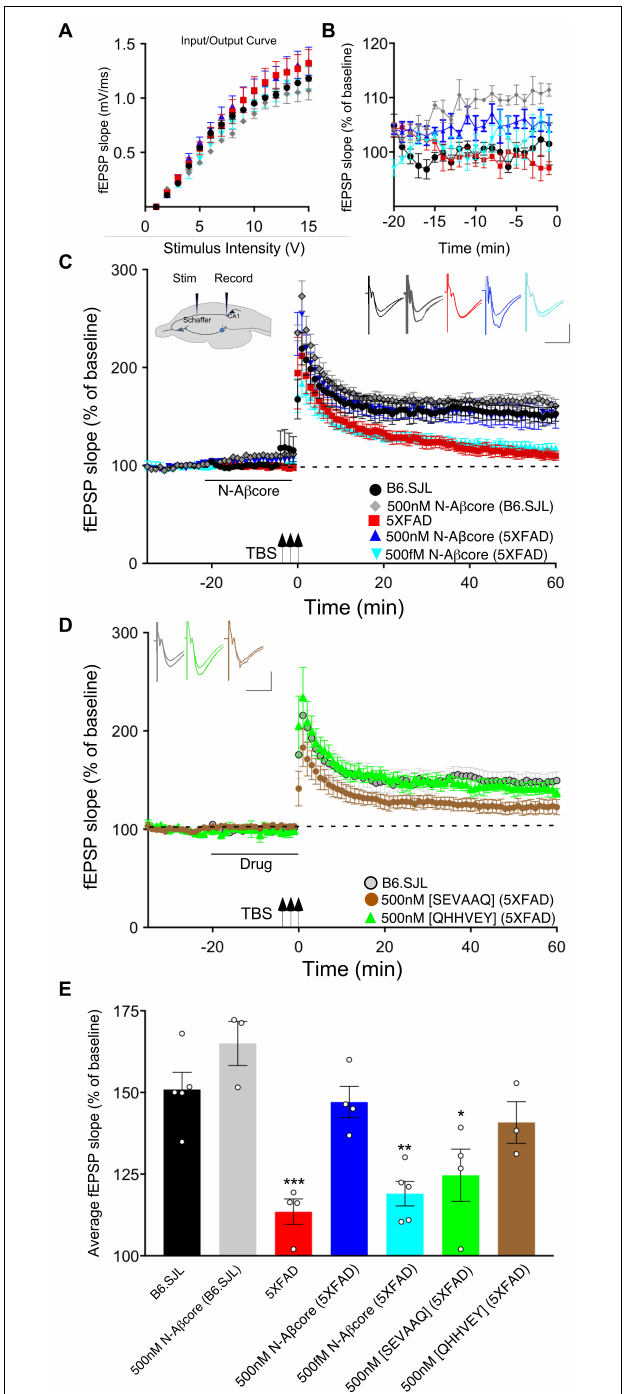
FIGURE 1 | The N-A β core reverses A β -induced synaptic impairment in APP/PSEN1 mutant mouse hippocampal slices. Input/output curves (A) plotting average fEPSP slopes versus stimulus strength before treatment and baseline recordings compared to panel (B) during the drug pretreatment period versus aCSF perfusion alone prior to stimulation for: control aCSF in B6.SJL slices (black, n = 5), 5xFAD slices (red, n = 4), 500 nM N-A β core in B6.SJL slices (gray, n = 3) and 5xFAD slices (blue, n = 4), plus 500 fM.